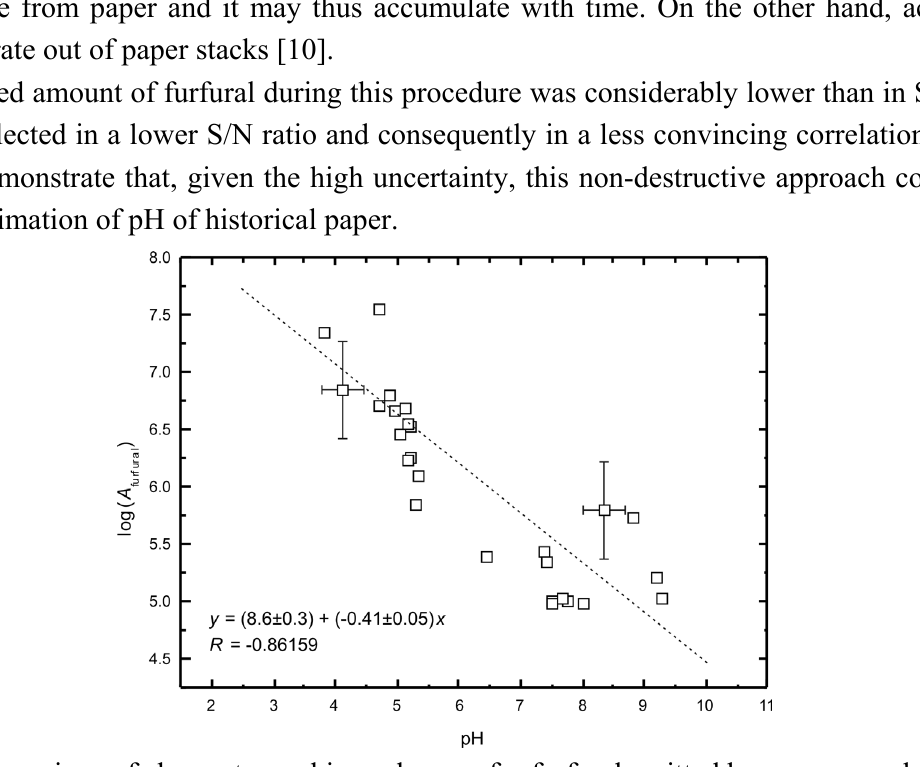
Figure 5. Comparison of chromatographic peak areas for furfural emitted by paper samples (Table 1) during contact sampling and equilibrium pH of the same samples. Error bars represent typical